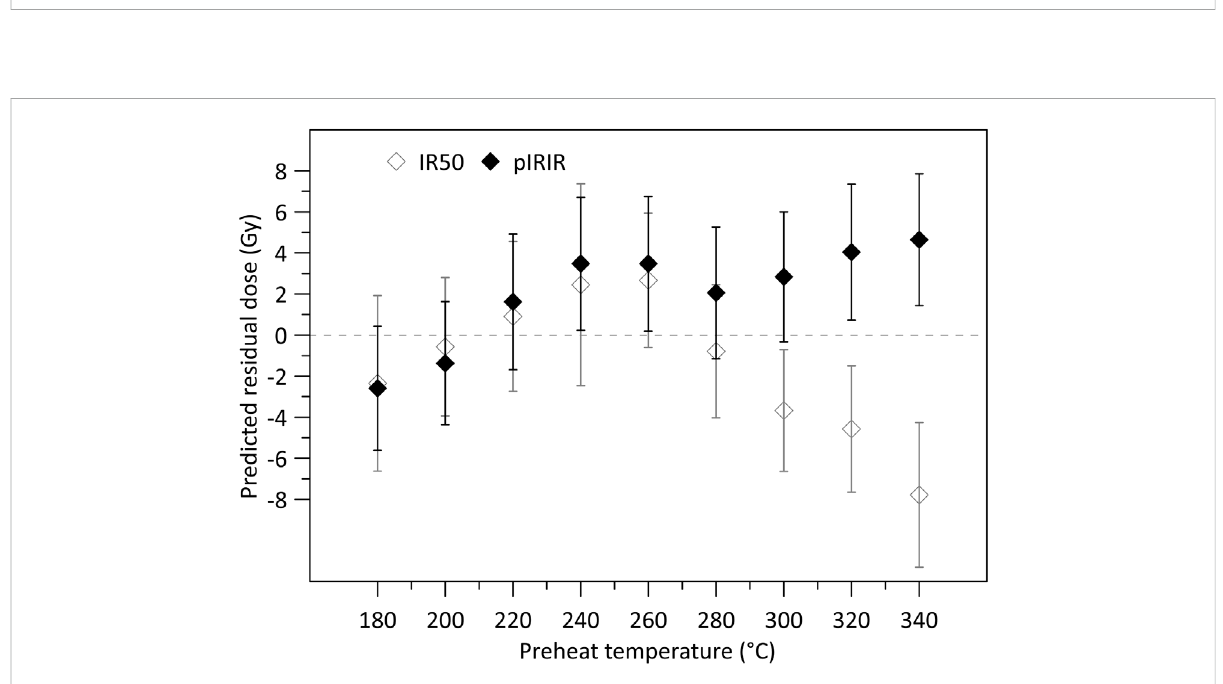
FIGURE 4 Predicted residual doses of the sample, corresponding to the differences between the fading-corrected D e s and the expected D e (30.8 ± 2.6Gy). The detailed data were presented in Table 2.